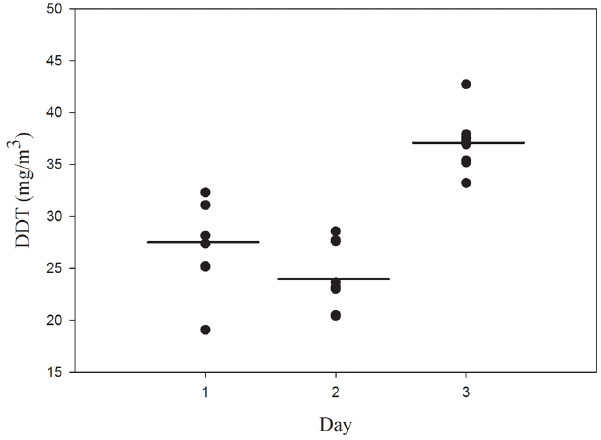
Figure 3. Scatter plot of DDT air concentration in samples collected on three separate days from the treatment chamber of the three chamber system. Polyester fabric treated with 0.9 g/m 2 4, 4 9 DDT was prepared each day and placed on 100% of the wall surface area of the treatment chamber. The mean airborne DDT concentration (denoted by a solid line for each day) was significantly different between days (one way ANOVA; F=33.664; P , 0.001). The DDT air concentration measured on Day 3 was significantly higher) than the levels measured on Days 1 and 2 (Holm-Sidak post hoc ; p , 0.001 for both comparisons). The DDT air concentration measured on Day 1 was significantly higher than the levels measured on Day 2 (Holm-Sidak post hoc ;